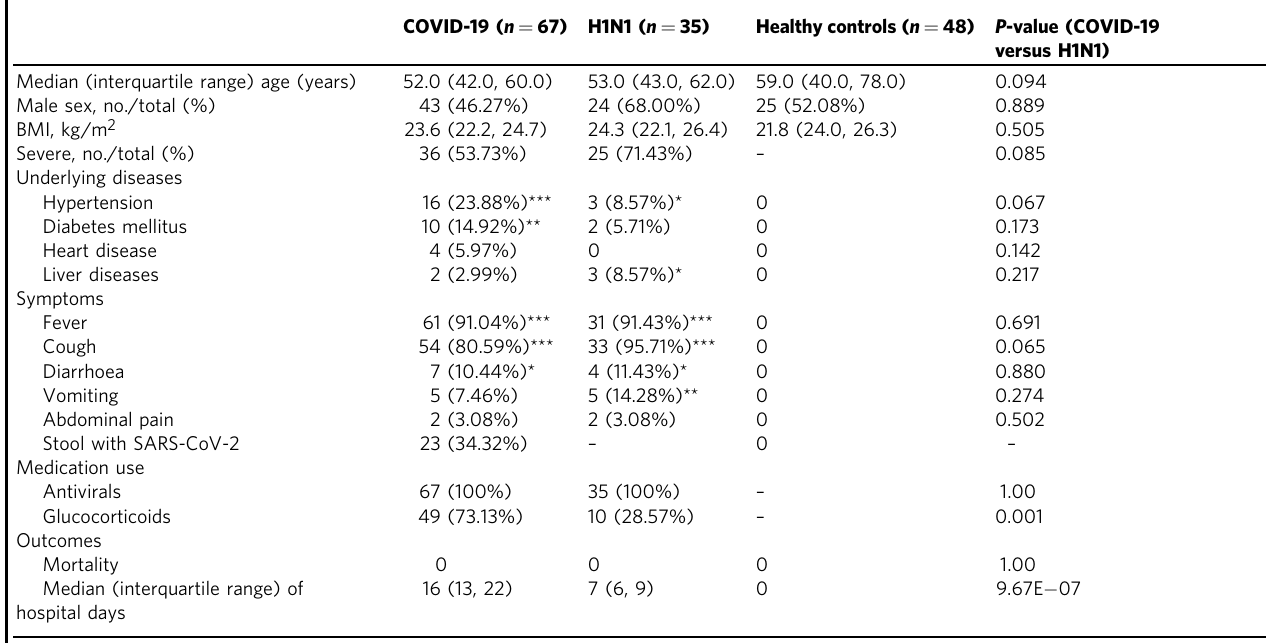
Table 1 Baseline characteristics and clinical